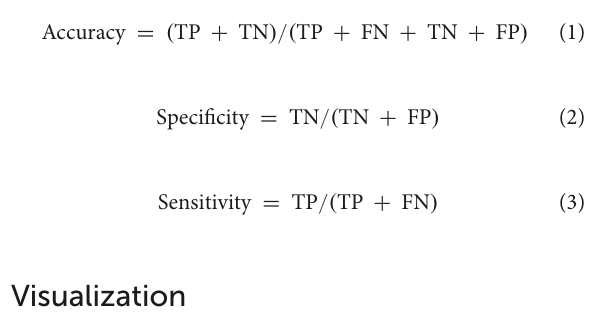
the convergence speed. Our model was trained with a